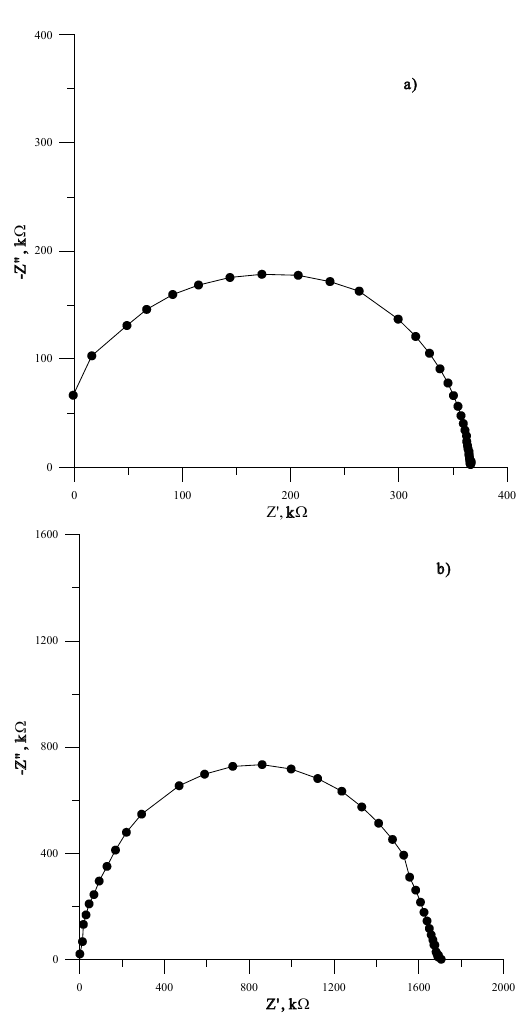
Figure 8. Complex impedance plot for zinc electrodes a) electrode no 6b containing BMImCl in the membrane b) electrode no 8 containing KTpClPB in the